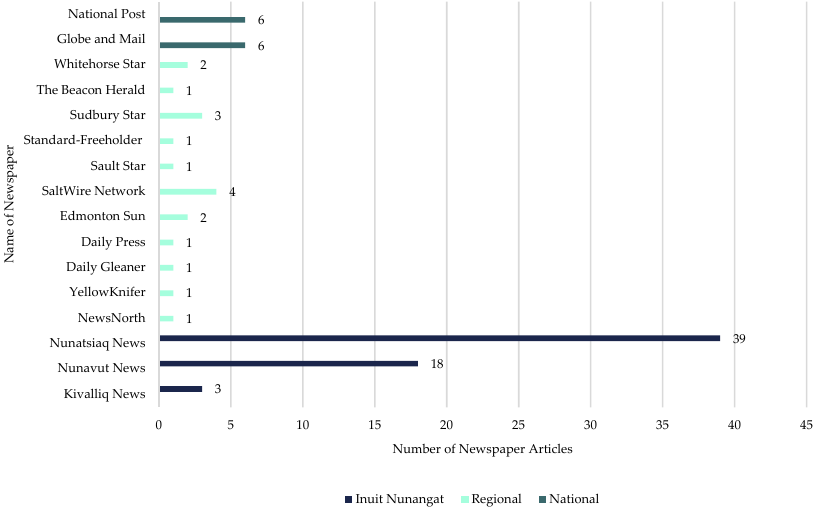
Figure 4. Number of articles, by publisher and region, of included articles on the mining industry’s initial response to COVID-19 in Inuit Nunangat from 1 January 2020, to 30 June 2020. The majority (67% of total articles/ n = 60 articles) of articles had a neutral valence (Figure 5). Most often the articles presented both positive and negative statements, which were categorized as having an overall neutral valence. For example, a National Post article from mid-April 2020 outlined Agnico Eagle’s ® efforts to resume production with on-site COVID-19 testing, this after a mine road blockade by residents in Rankin Inlet forced the company to act quickly and send home local workers: In March, the company scaled back operations at the mine after local residents staged a roadblock to protest the risks posed by flying workers in. Since then, the Nunavut-based workforce is no longer coming to the mine and the workers that are flown in are not interacting with the community. But with no date in sight for when the coronavirus threat will pass, the company is laying the groundwork for an eventual resumption of operations. Instead of waiting for COVID-19 test samples to travel thousands of kilometres to a lab in lower Canada, the company will be able to know within a matter of hours if someone on the site is infected [57].